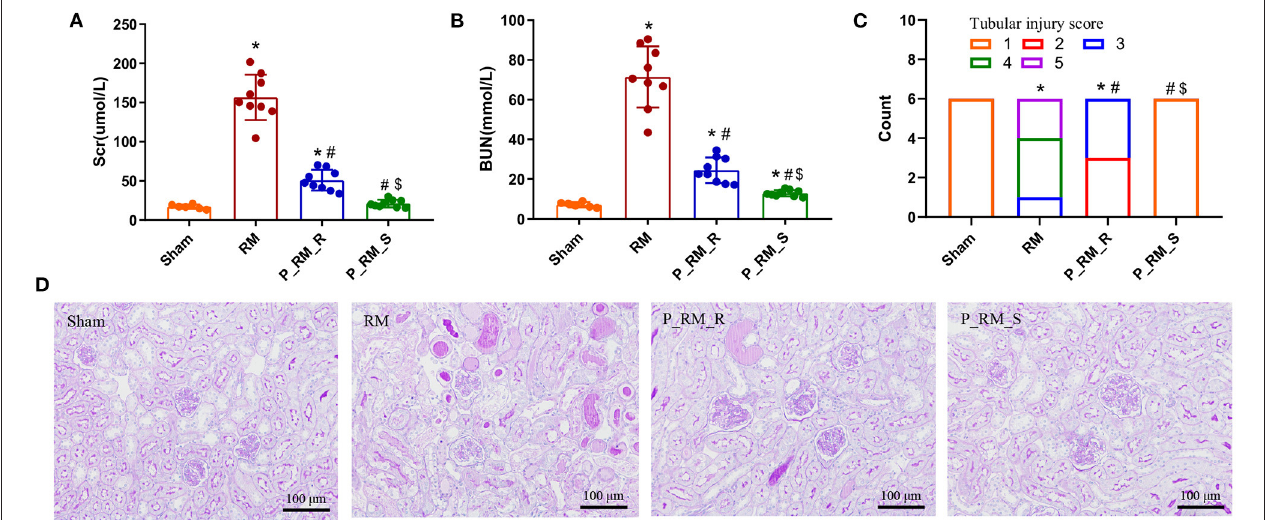
FIGURE 1 | Exogenous biological renal support attenuated the histological and functional deterioration in RM-induced AKI. (A) Scr levels in the four groups. (B) BUN levels in the four groups. (C) Renal tubular injury scores. (D) Representative photographs of kidney sections stained with periodic acid–Schiff (200 × magnification). The values are presented as means ± SD. Scr, serum creatinine; BUN, blood urea nitrogen; RM, rhabdomyolysis; P_RM_R, the mouse in the parabiosis model administered glycerol; P_RM_S, the other mouse in the parabiosis model that supplied the exogenous biological renal support. * P < 0.05 vs. the sham group; # P < 0.05 vs. the RM group; $ P < 0.05 vs. the P_RM_R